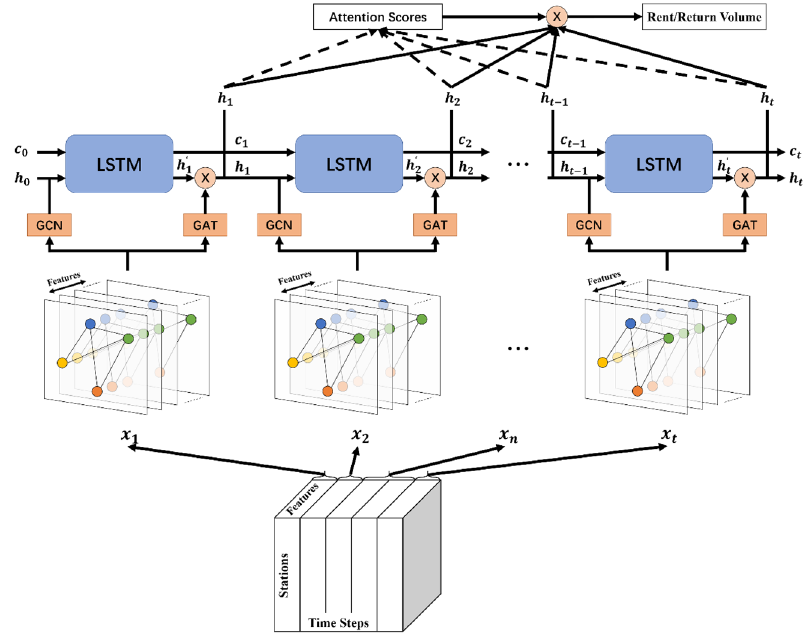
Figure 3. The whole process of the STGA-LSTM